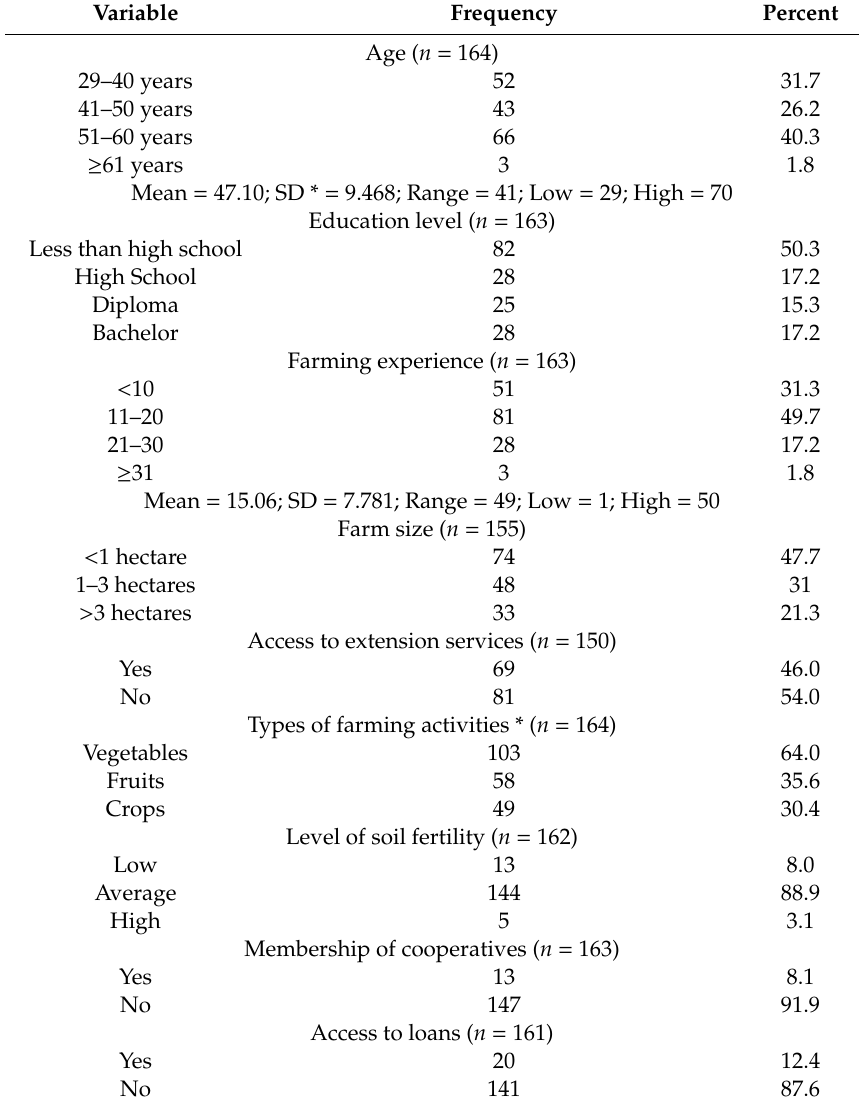
Table 1. Demographic profile of